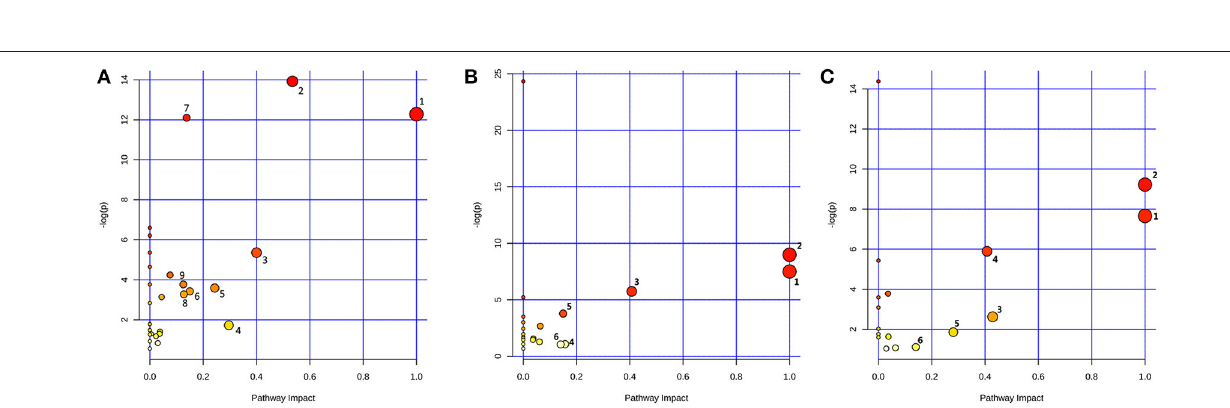
Frontiers in Pharmacology |